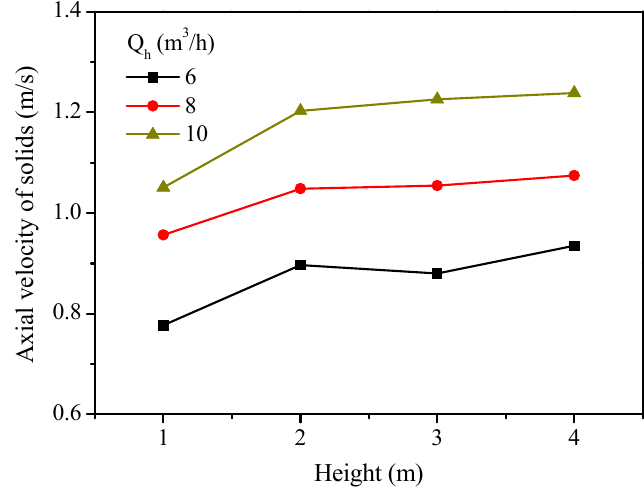
Figure 10. Solids axial velocities in different steam flow as a function of height.